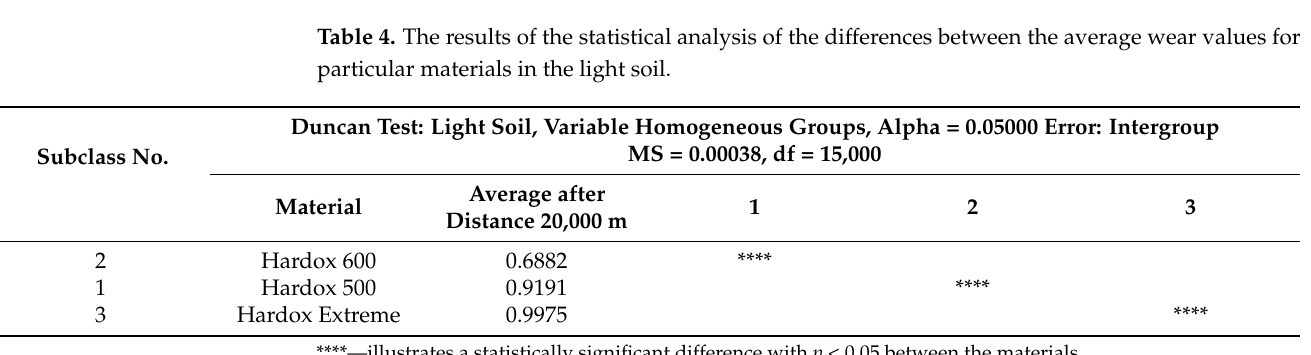
Table 5. The results of the statistical analysis of the differences between the average wear values for particular materials in the medium soil.